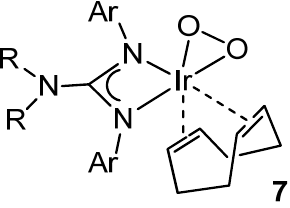
Figure 43. Dioxygen iridium complex.